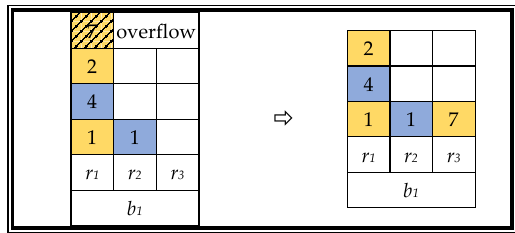
Figure 10. Stack overflow solution strategy.